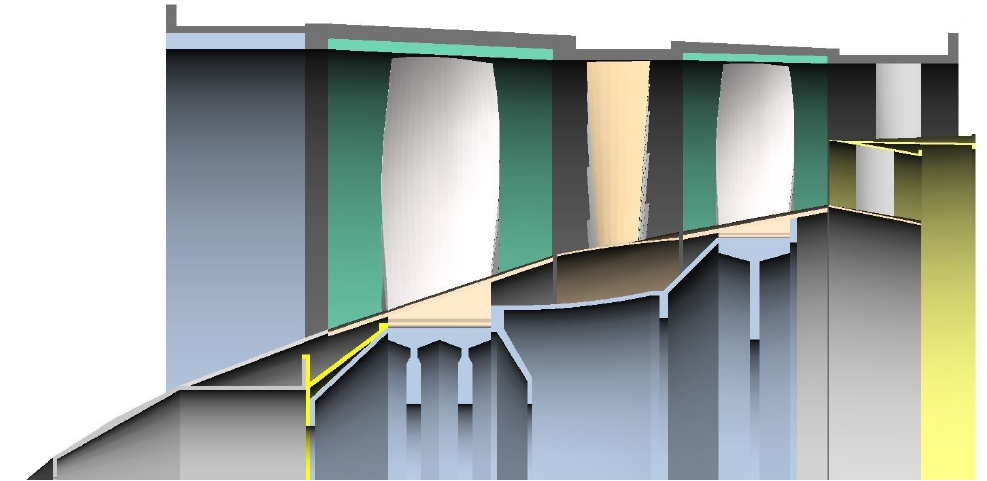
Figure 4. Preliminary fan design model showing different stage